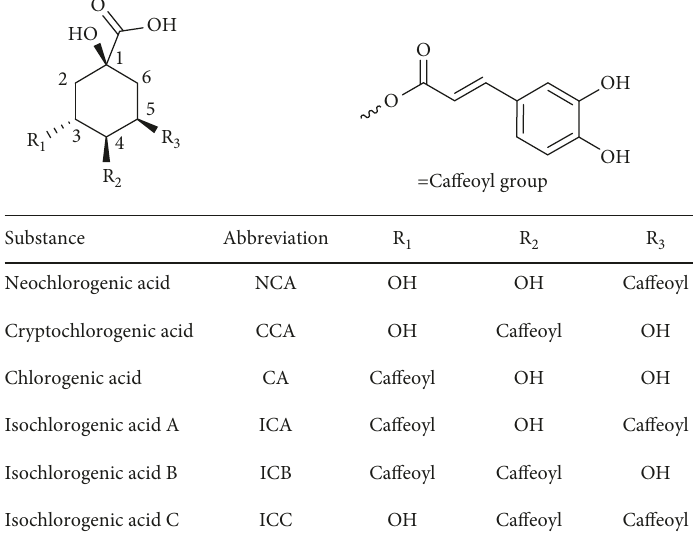
Figure 1: Chemical structures of six